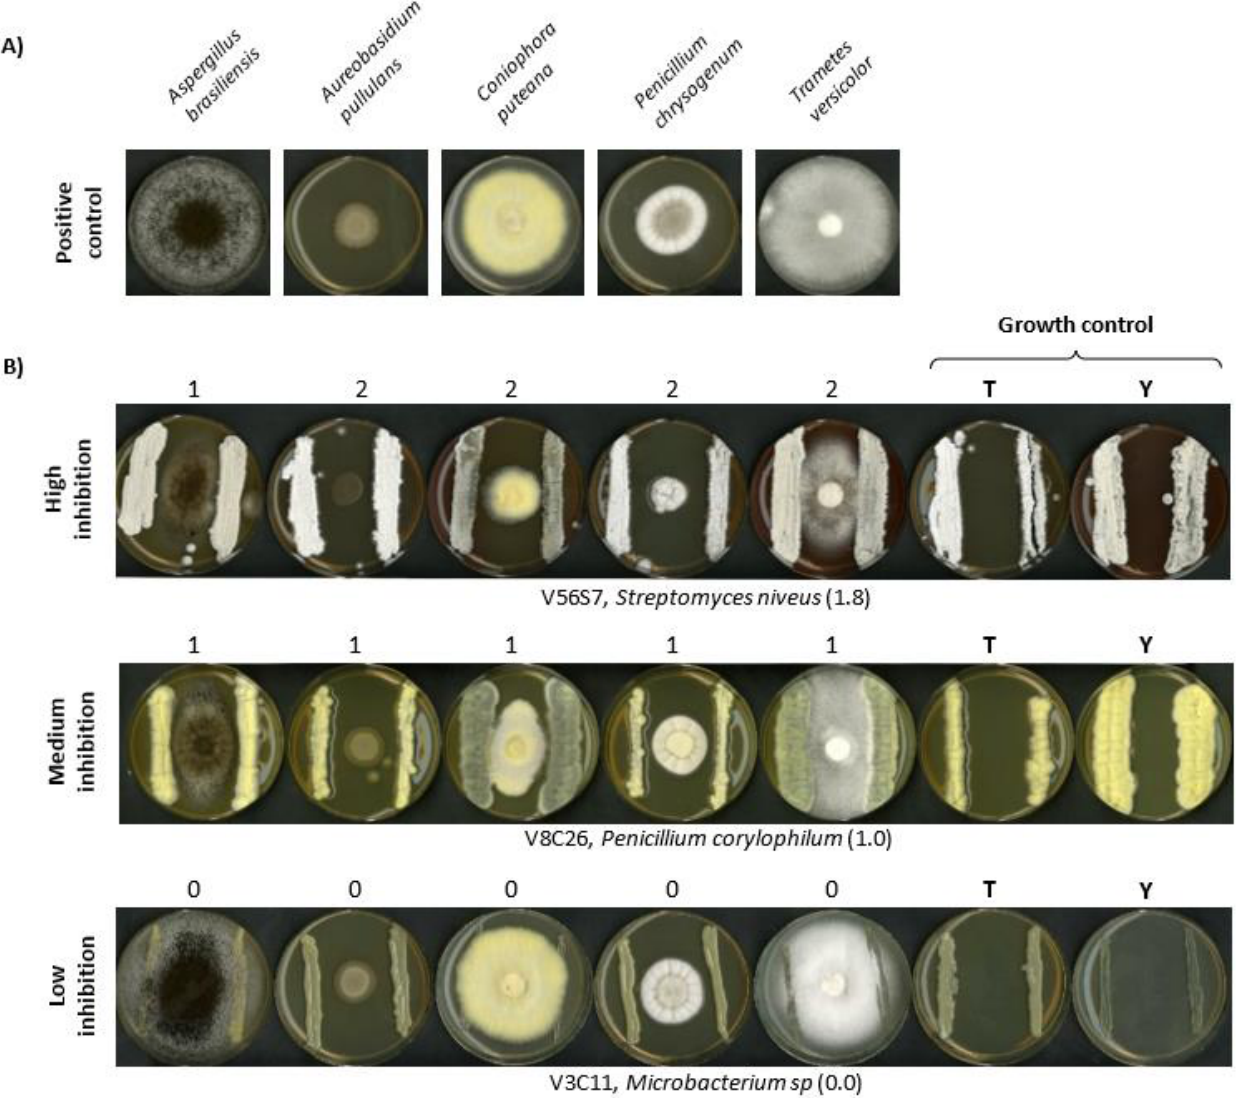
Figure 5. Examples of the evaluation of the antifungal activity in the bioassays. ( A ) Control—reporter species growing on selected medium Trypticase Soy Agar (TSA) or Yeast Extract Malt Extract (YEME) without antagonists (“positive control,” see Materials and Methods): A. brasiliensis , A. pullulans , C. puteana , P. chrysogenum , and T. versicolor . ( B ) Competitive bioassay with the reporter spe- cies in the centre and the antagonistic species at both sides—Actinobacteria ( Streptomyces niveus or Microbacterium sp.) or Penicillium corylophilum ]. The antagonistic species were plated alone as growth controls (right: growth control) on the selected media TSA (T) and YEME (Y). The bioassay was evaluated by comparing the growth of the reporter species alone versus in the presence of an- tagonists. The intensity of the inhibition was rated from 0 to 2, where 0 is no inhibitory effect and 2 is total inhibition. The average score of each antagonistic microorganism is shown in parenthesis. Nevertheless, this is the first time that high antifungal activity is being reported for this species. Another example is S. fimicarius V56S1, which showed high fungal inhibition capacity (1.8) and was positive for PKS-II and NRPS (Supplementary Table S2 and Sup- plementary Figure S5). Strains of this species have shown antifungal activity due to the production of volatile organic compounds towards the oomycete pathogen Peronophythora litchi , which causes downy blight in lychee ( Litchi chinensis Sonn.) [75]. Penicillium species that contained three or more positively detected gene fragments were also selected for antifungal activity assay. A total of 16 Penicillium isolates were tested. A total of 2 isolates exhibited high inhibition capacity against the fungal reporter